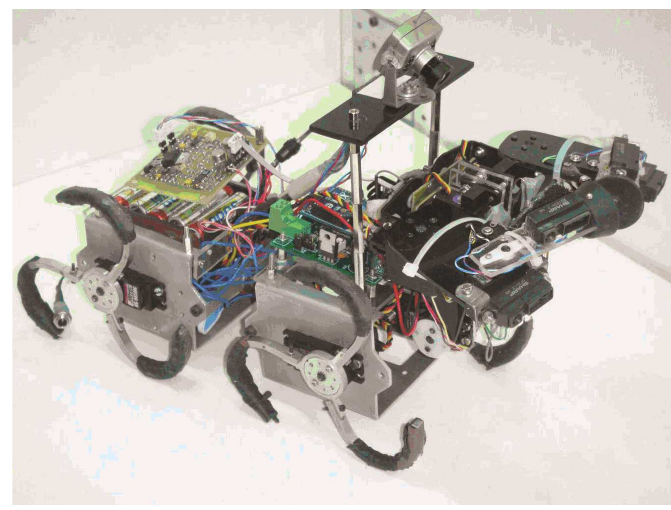
Figure 11. Robotic prototype including a frontal manipulator module and two carts with whegs.